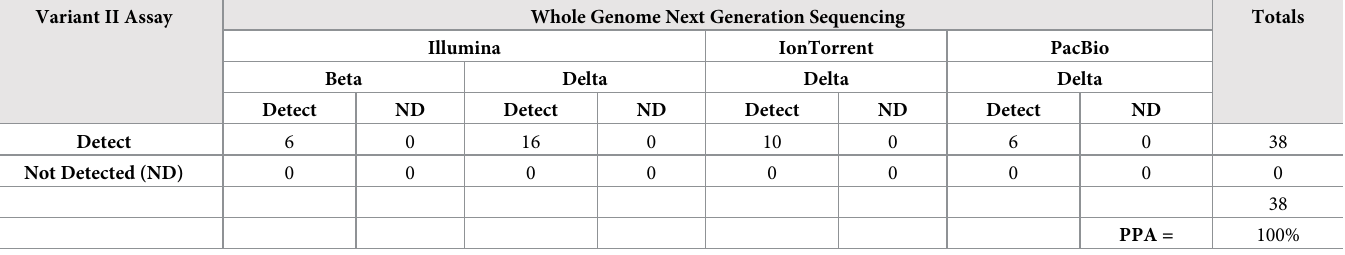
Table 2. Accuracy of Variant II assay in detecting variants confirmed by whole genome sequencing. A total of 38 sequenced confirmed variants were analysed by the Variants II assay. Of the 38 sequenced samples, 22 were sequenced by Illumina MiSeq, 10 by IonTorrent Genexus and 6 by PacBio Sequel IIe (see Materials and methods). Variant II